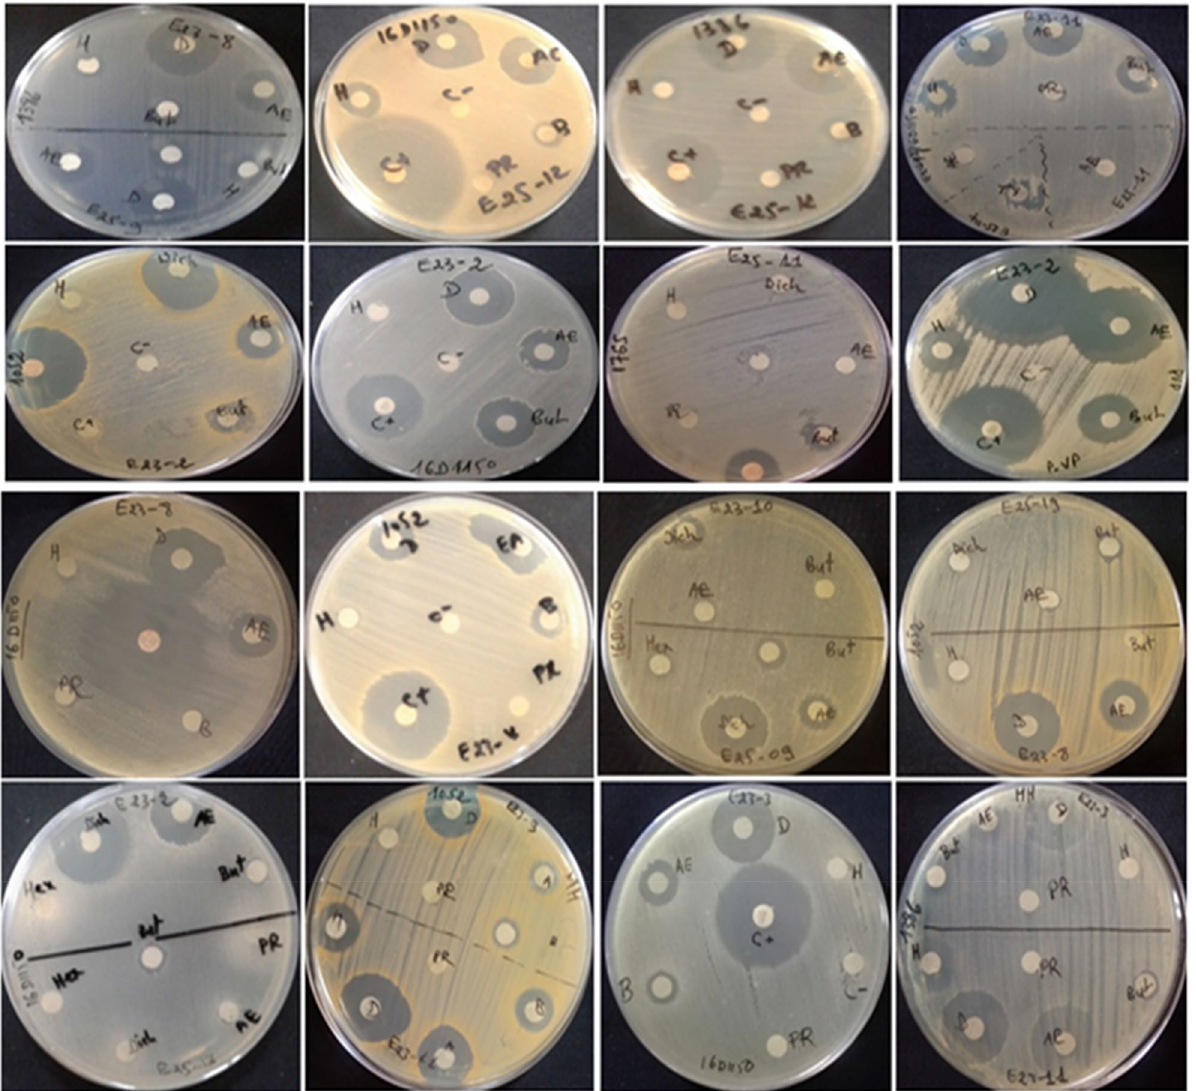
Figure 6. Secondary screening (antibacterial activity) by the disc diffusion method on MH medium.